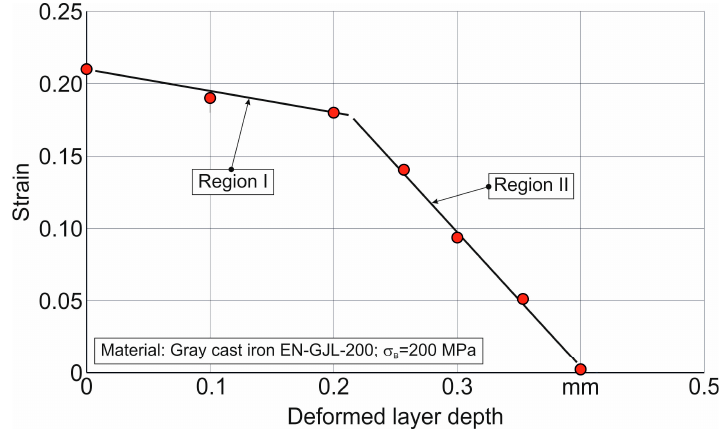
Figure 8. Strain variation along the depth of the deformed layer.